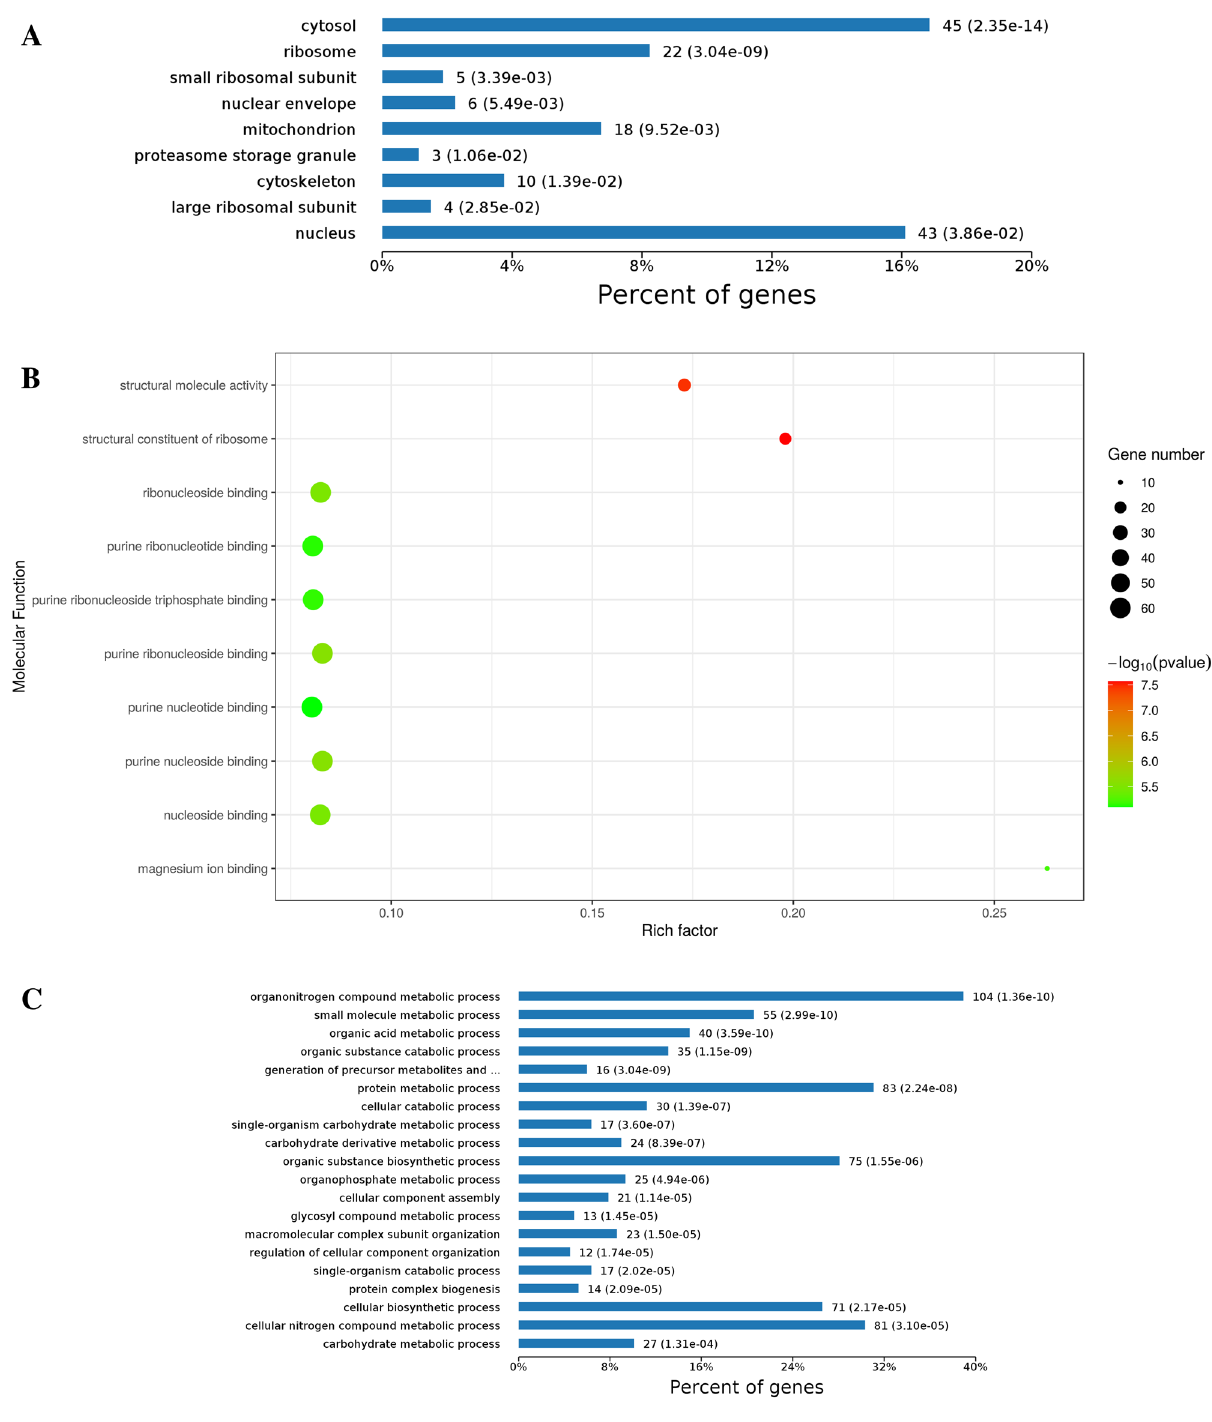
Figure 1. Acetylated proteins bioinformatics analysis and enrichment results in P. umbellatus including cellular localizations ( A ), molecular functions ( B ), and biological processes ( C